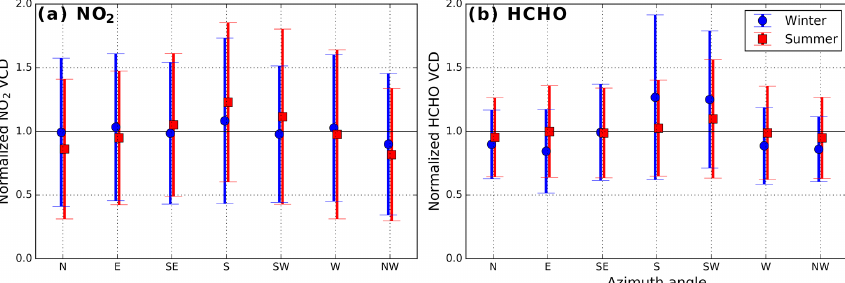
Figure 4. Normalized MAX-DOAS measurements of (a) NO 2 and (b) HCHO VCD for different viewing azimuth angles for winter (De- cember, January and February, blue markers) and summer (June, July and August, red markers). The data are normalized by dividing the corresponding mean VCD. Error bars indicate the 1 σ standard deviation variation